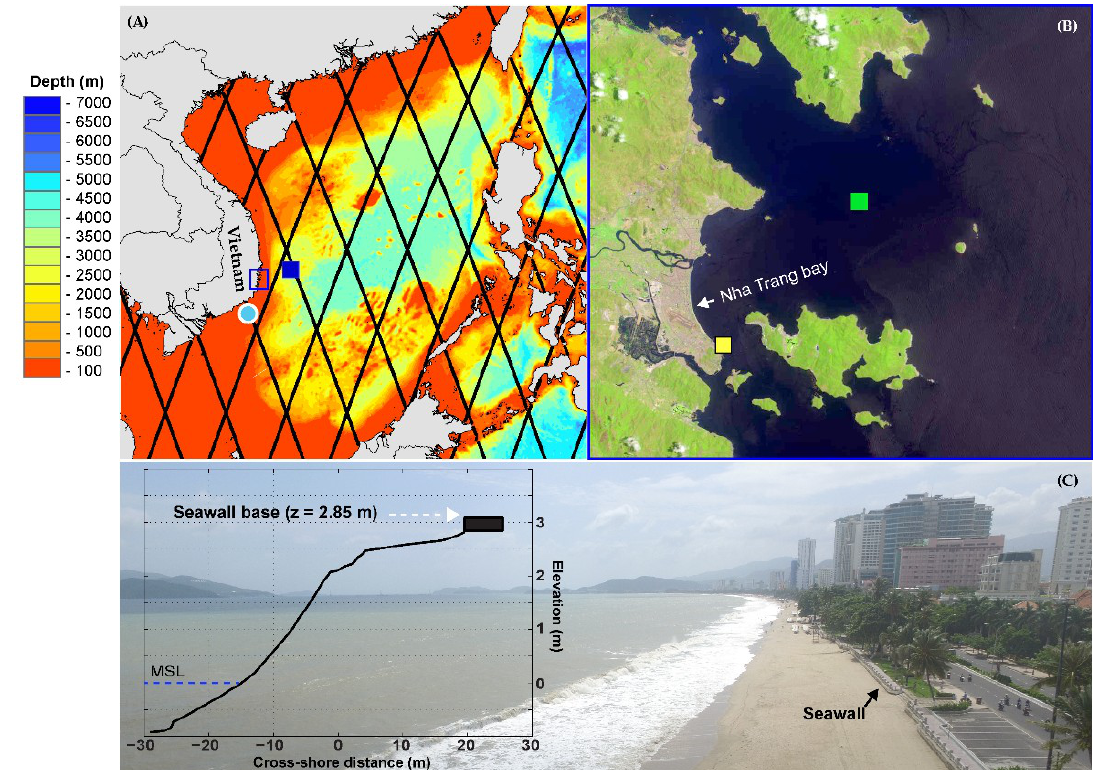
Figure 1. Study site location. ( A ) South China Sea bathymetry indicating the ERA‐interim (reanalysis dataset produced by the European Centre for Medium‐Range Weather Forecasts—ECMWF) wave grid point (blue filled box), satellite altimetry tracks used to produce the gridded sea-level products (black lines) provided by the Copernicus Marine Environment Monitoring Service (CMEMS), and the location from where altimetric non‐tidal residual (NTR) were extracted (blue circle); ( B ) zoom of Landsat image showing the location of Nha Trang Bay and the position of the local tide gauge (yellow box) and the closest tide model grid point (green box); ( C ) view of Nha Trang beach with the location of the seawall and a graph of the average beach profile geometry.